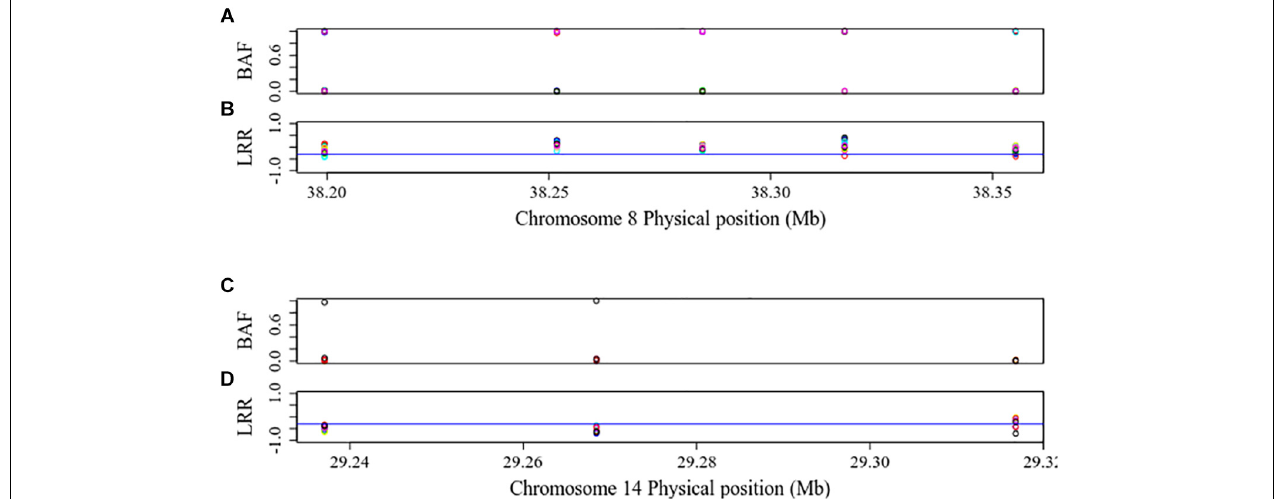
FIGURE 3 | BAF and LRR in a ROH existing in 28 individuals from 15 breeds (Abergelle, Diana, Guéra, Gumez, Keffa, Landim, Menabe, Naine, Nsanje, Red Sokoto, Small east African, Sofia, SudOuest, Thyolo, and West African Dwarf) on CHI8 (38,199,425 to 38,355,253 bp) (A,B) and in a ROH-CL in 10 individuals from 6 breeds (Cameroon, Diana, Karamoja, Menabe, Small east African, and West African Dwarf) on CHI14 (29,237,079 to 29,316,817 bp) (C,D) . The blue lines are LRR cut-off points of –0.3, below which the signal intensity may mean that there is only one allele, implying copy